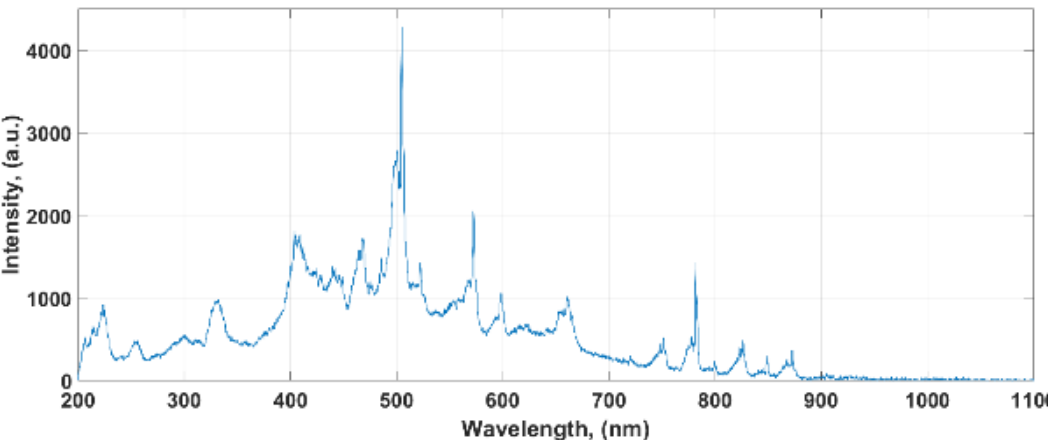
Figure 4. Examples of spectral characteristics for an electric arc generated in the air at a voltage of 4 kV DC.